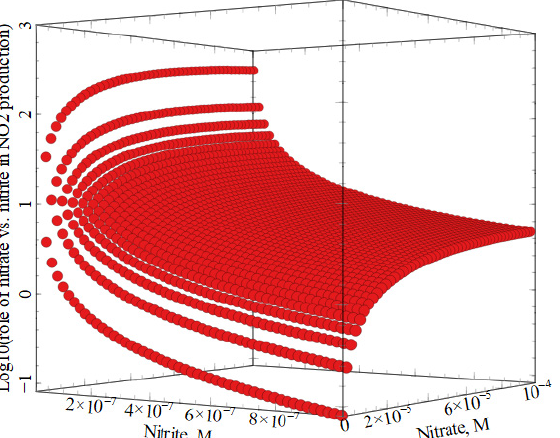
Figure 4. Comparison between the contributions to • NO 2 generation by nitrate photolysis